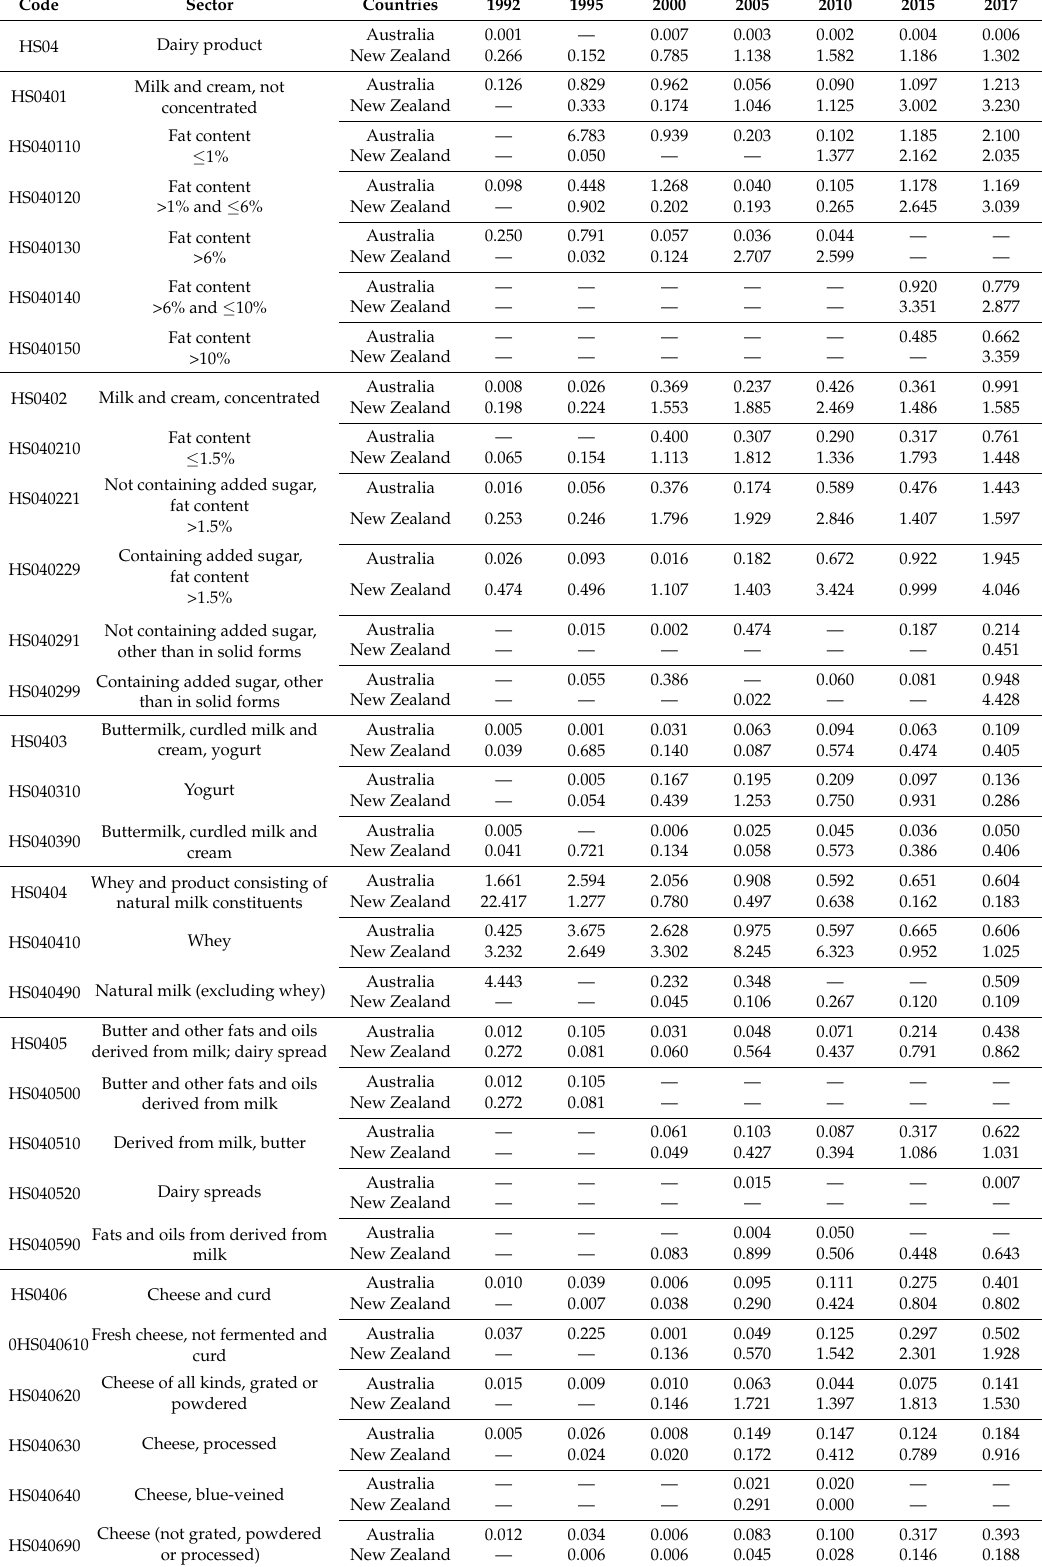
Table 6. Revealed Competitive Advantages (RCA) in the Dairy Trading of Australia and New Zealand in China market. (Revealed comparative advantage index RCA i = X i / X , X i , X wi means dairy export X wi / X w of country i to China and the world, X , X w means the total export of country i to China and the world. When the RCA is calculated here, added value is used instead of total exports in order to avoid